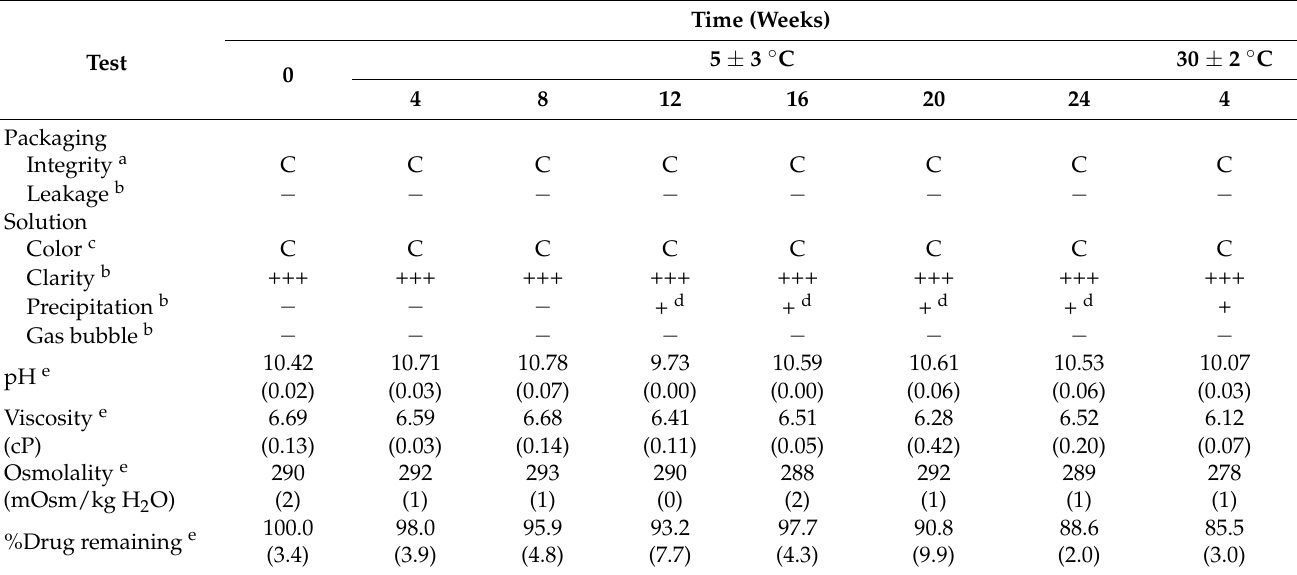
Table 7. Stability results of ganciclovir/HYA0.3 ED after storage at 5 ± 3 ◦ C and 30 ± 2 ◦ C. The numerical results are expressed as mean